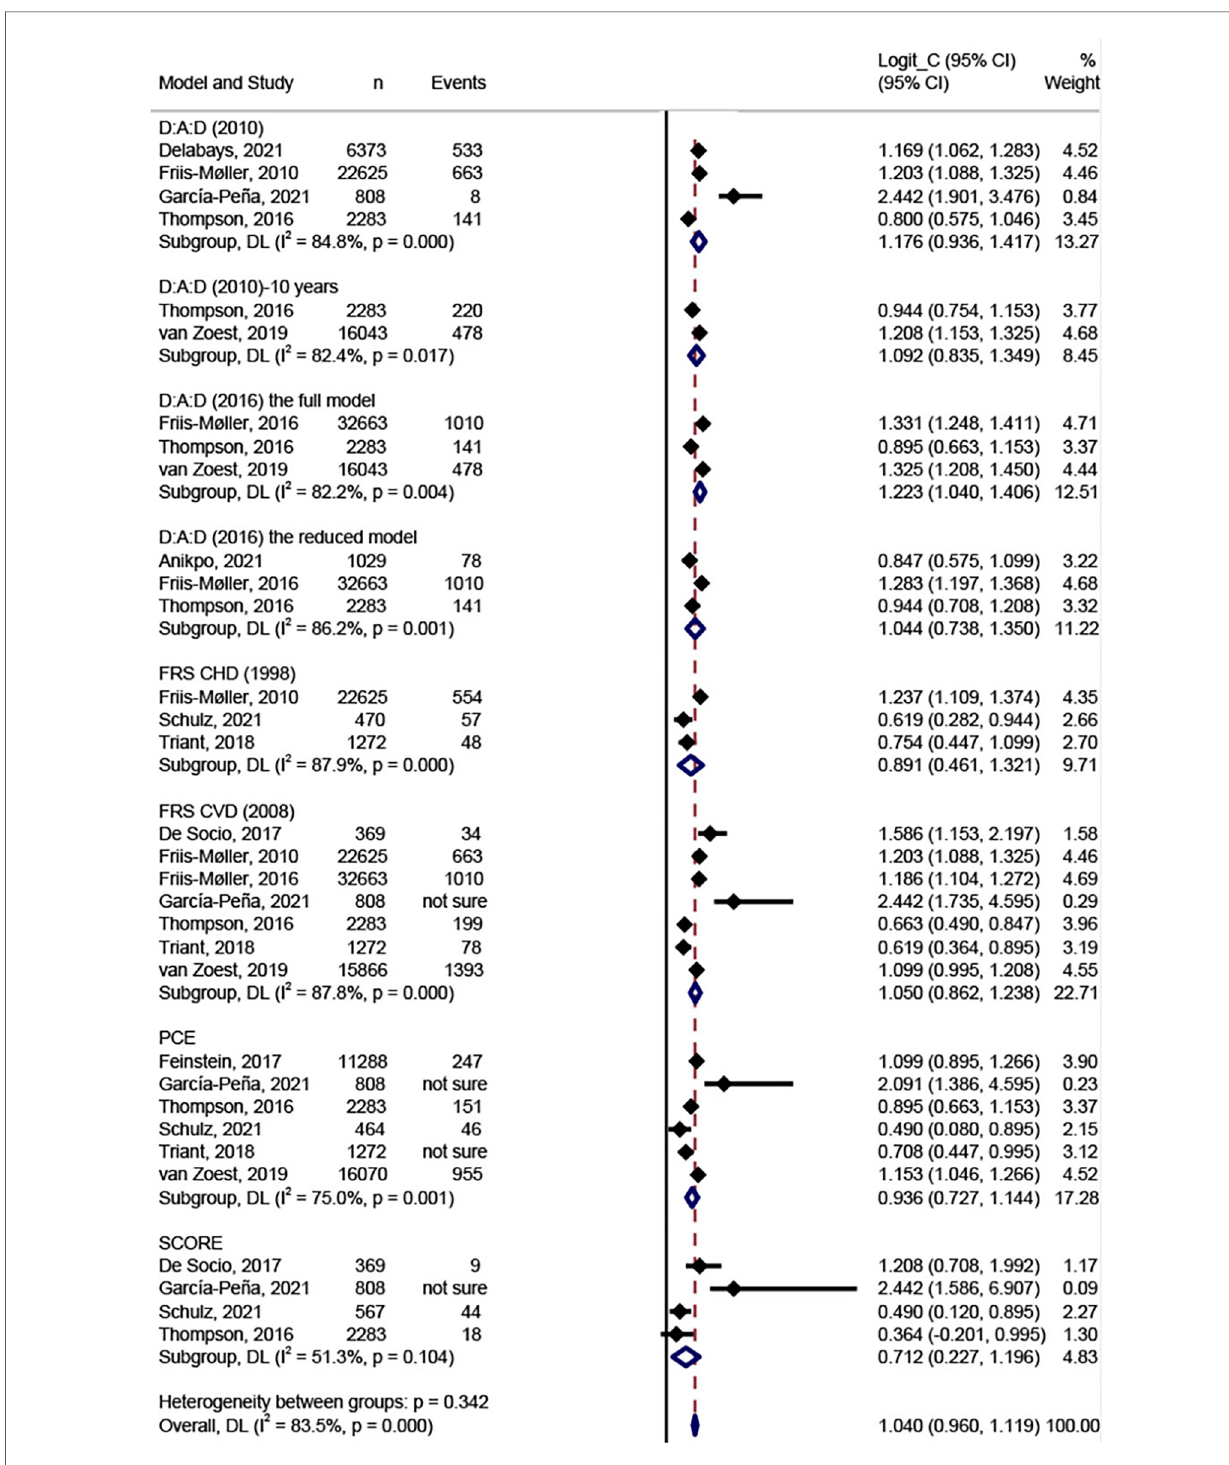
FIGURE 3 Meta-analysis of the C-statistic for the CVD prediction models in